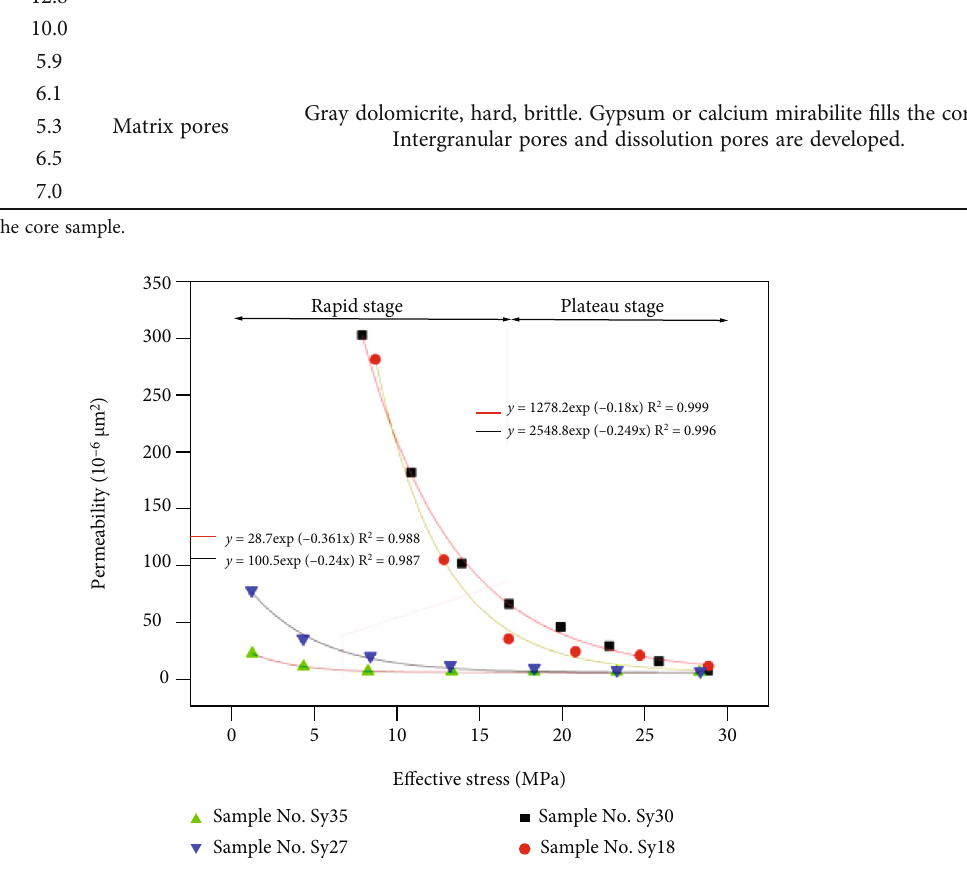
Figure 7: Plot of the oil phase permeability vs. e ff ective stress. Sy30 and Sy18 are fractured cores; and Sy35 and Sy27 are matrix